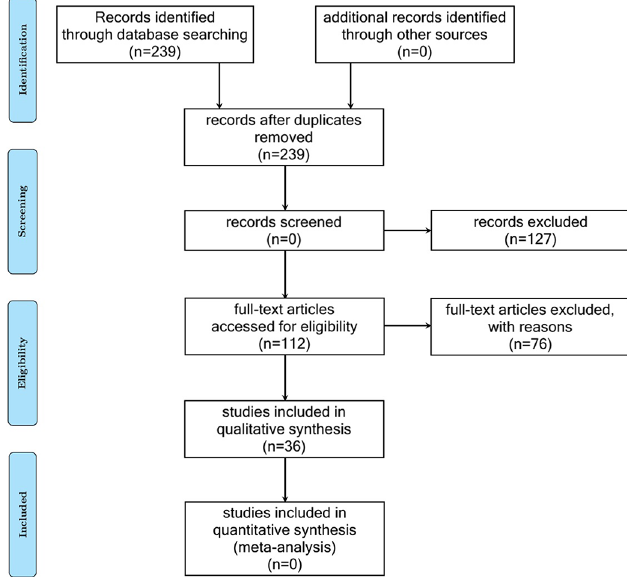
Fig. 1. Flow chart, Preferred Reporting Items for Systematics Review and Meta-Analyzes (PRISMA)